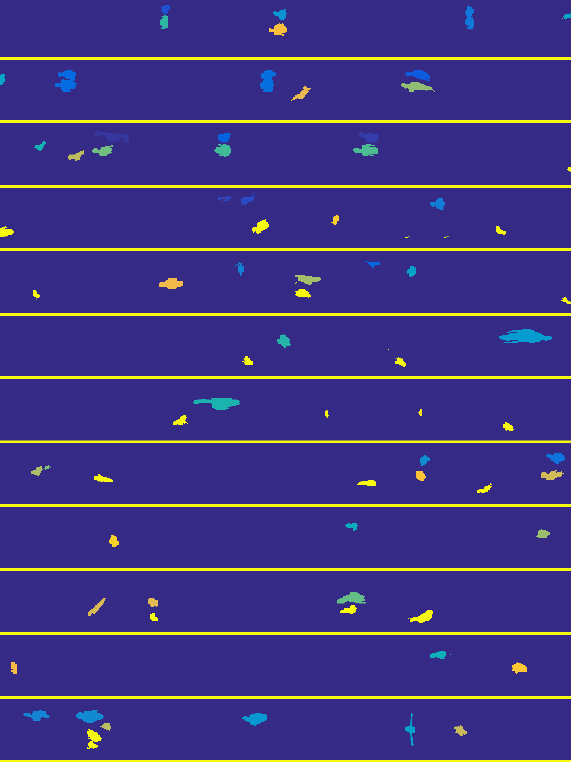
Figure 4. The Kinect depth image validation with the binarizing steps and the visualization of the optical image